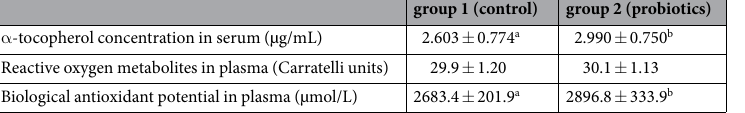
Table 4. α -Tocopherol concentration, reactive oxygen metabolites, and biological antioxidant potential (mean ± SD). a,b Different letters within rows indicate differences between treatment groups ( p <